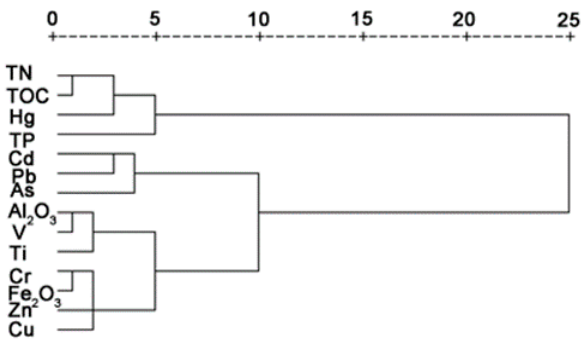
Figure 4. Hierarchical agglomerative cluster (CA) of the elements contents in the surface sediments of Nansi Lake.